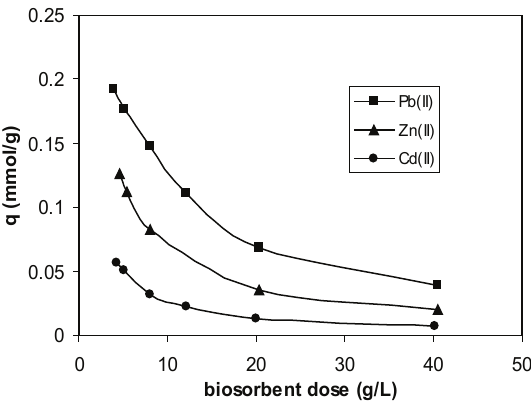
Figure 3 : Effect of biosorbent dose on the biosorption of heavy metals onto mustard waste biomass (pH = 5.5; c M(II)/L; contact time = 24 hours; t = 20 °C).